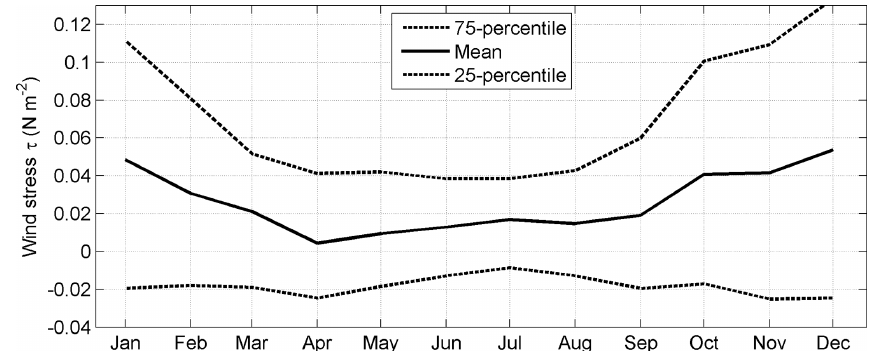
Figure 7. Annual cycle of an along-gulf component of wind stress. Mean (solid black curve, positive eastward) and 75 and 25 percentiles (dashed lines) are based on data from 1981 to 2015, measured at Kalbådagrund Lighthouse, Gulf of Finland.